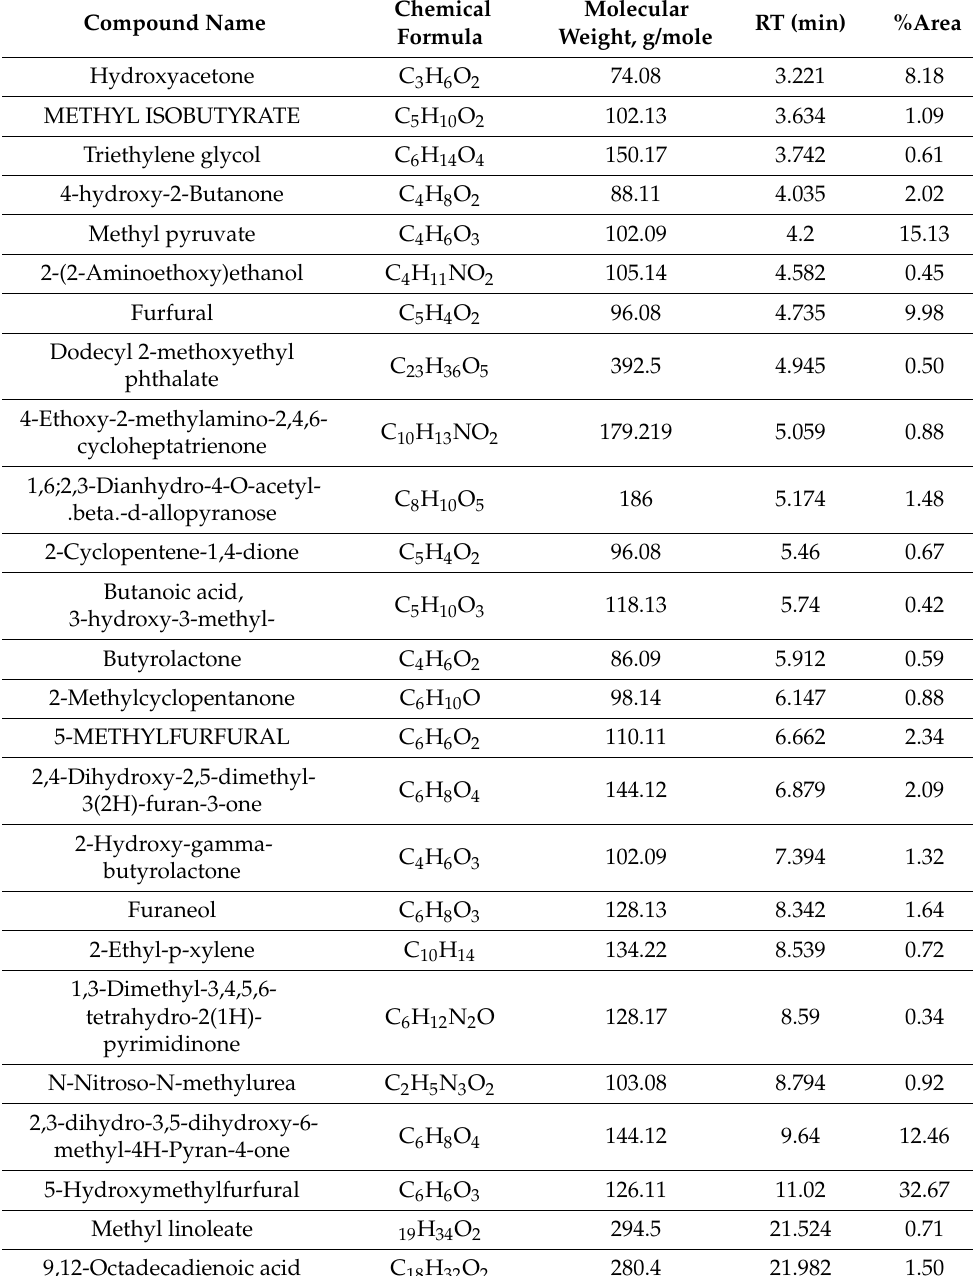
Table 1. GC-MS analysis of beetroot peel methanol